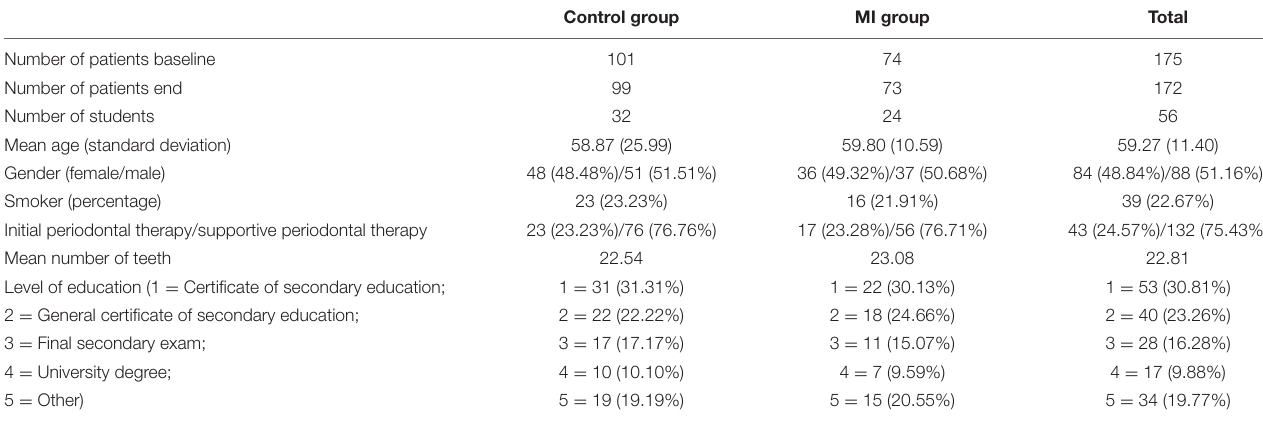
TABLE 1 | Demographic characteristics of the